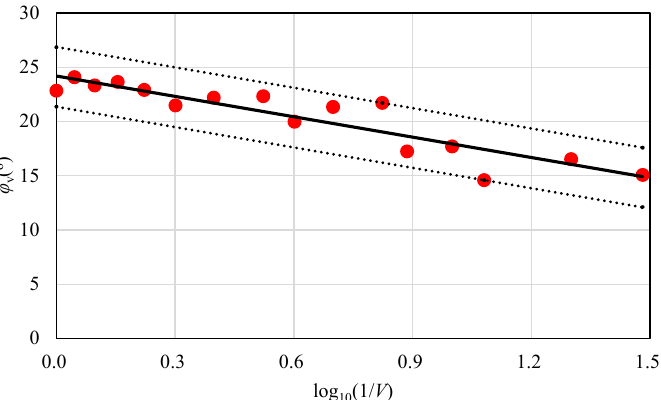
Figure 5. Relationship between average value of the rate-dependent friction angle ϕ v and log 10 (1 / V ) of granite discontinuity samples.